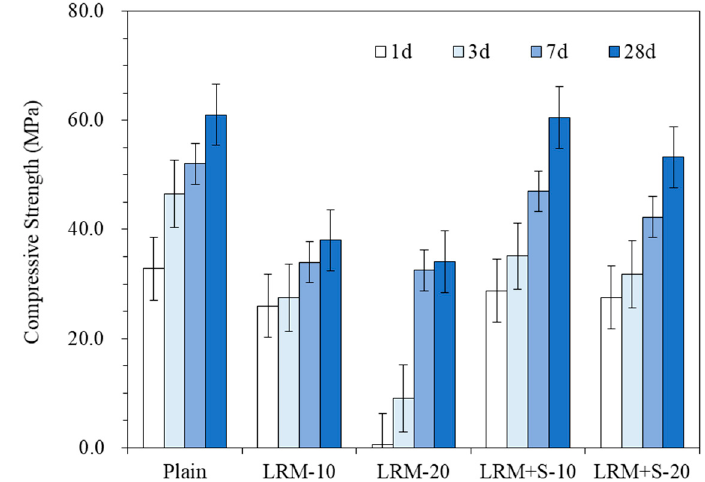
Figure 5. E ff ects of LRM and LRM + S on the compressive strength of the cement Figure 5. Effects of LRM and LRM + S on the compressive strength of the cement paste.